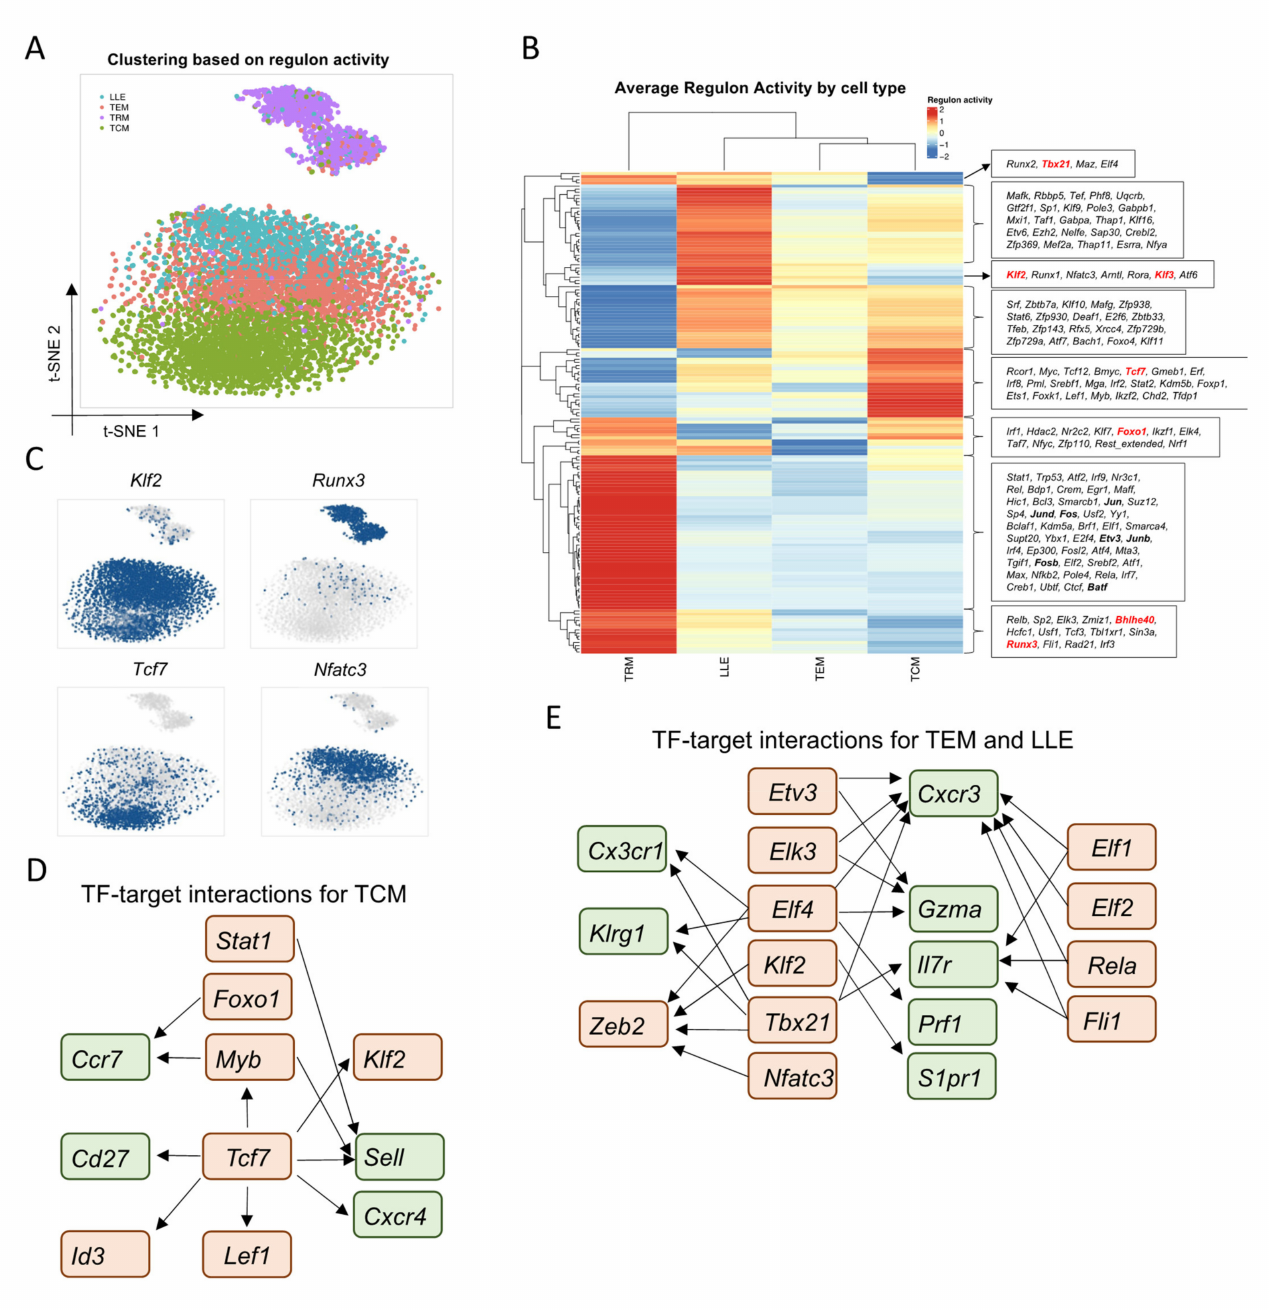
Figure 2. Single-cell network inference reveals candidate regulators of memory CD8 + T-cell populations: ( A ) Unsupervised clustering based on regulon activity separated cells into four major populations when visualized by t-SNE. Colors denote the CD8 + T-cell subsets identified by gene expression profiles in Figure 1. ( B ) Heatmap showing the average regulon activity in each cell population. Scale bar denotes SCENIC AUC score. ( C ) t-SNE projections showing binary regulon activity of example regulons for different memory subsets. ( D , E ) Gene regulatory networks showing TF-target interactions for TEM, LLE, and TCM. Key TFs are highlighted in red, putative regulated genes are highlighted in